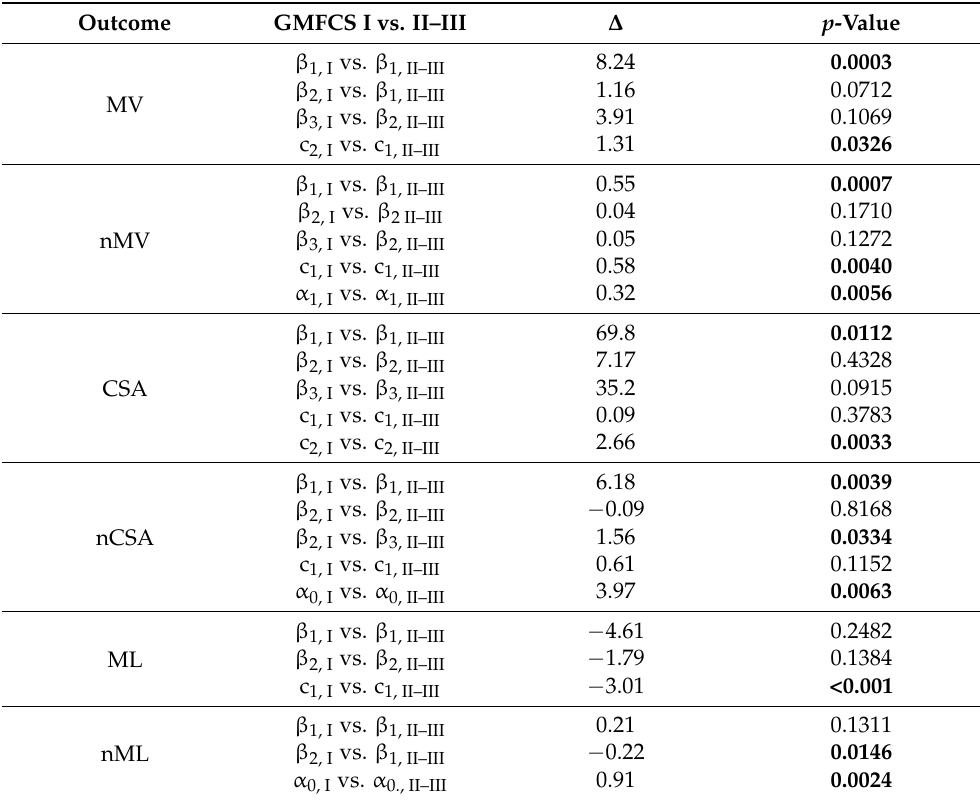
Table 3. Results of the comparison in slopes and breakpoints between the GMFCS